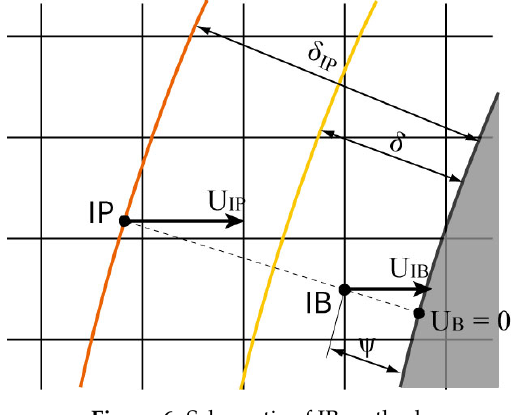
Figure 6. Schematic of IB